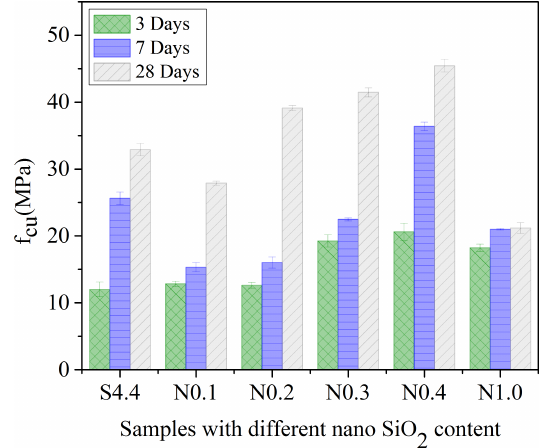
Figure 9: Effect of W/S ratio on setting time